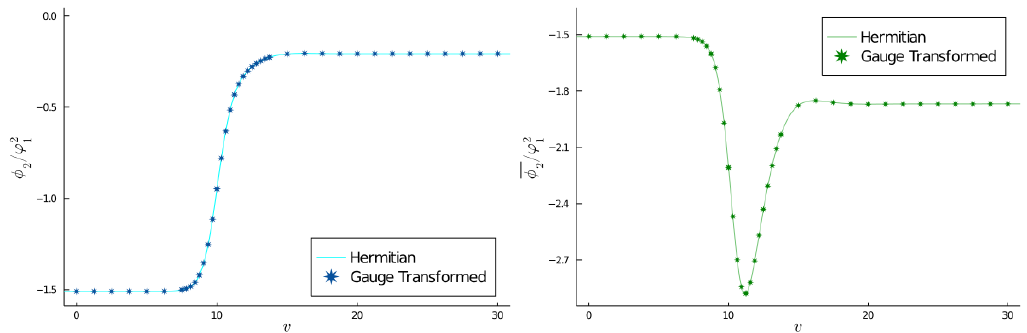
Figure 9: Subleading coefficients of both scalar fields as defined in 2.20 for simu- lations B, labelled as Hermitian, and for simulation A once we perform the gauge transformation, labeled Gauge Transformed. Both simulations overlap and are phisi- cally